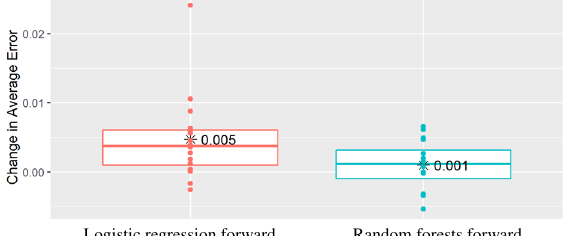
Figure 3: Resulting change in average class error if the models are trained on the variable sets produced for specifically for the other learning algorithm by forward selection. Colored points denote the performance (percentages of falsely classified superpixels) of the relevant algorithm for any of 16 single images. The colored lines and stars represent average and median values,